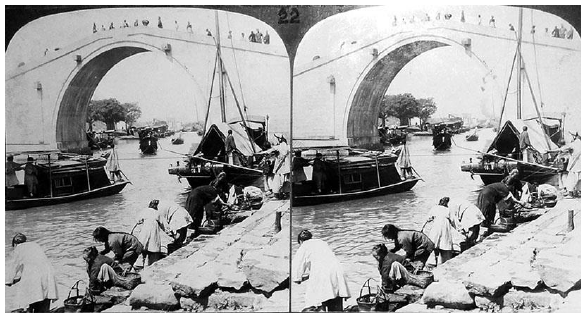
Figure 2. Historic masterpieces of scenery at women bride of the Imperial Canal near Soo-Chow (China) (by Underwood &Underwood, approx. 1900)